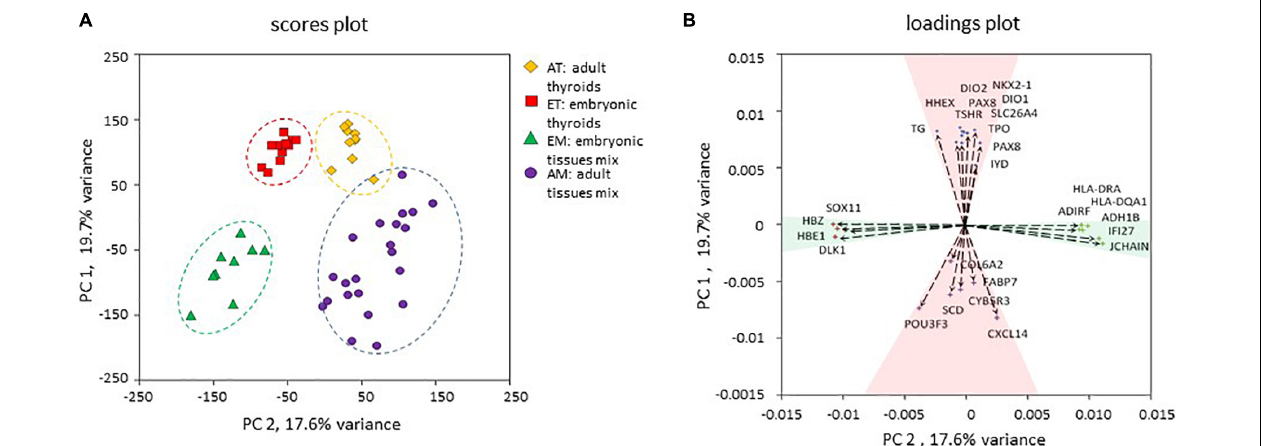
FIGURE 3 | Principal component analysis. (A) Principal component analysis of the four transcriptomic datasets used in the study. The position of each data point corresponding to an individual transcriptome is determined by the first principal component (PC 1) and second principal component (PC 2) scores. PC 1 and PC 2 resolved samples according to their thyroid identity and developmental stage respectively. (B) Contribution of individual genes to PC 1 and PC 2. Genes with the strongest upregulation in thyroid compared to non-thyroid samples (TPO, TG, TSHR, NKX2-1, PAX8, HHEX, FOXE1, DIO1, DIO2, IYD) and genes with the strongest upregulation in other tissues compared to thyroid (SCD, COL6A2, FABP7, POU3F3, CYB5R3, CXCL14) were among the strongest contributors to the PC 1. Non-tissue-specific genes that demonstrated a higher expression in adult tissues (JCHAIN, HLA-DQA1, ADH1B, ADIRF, HLA-DRA, IFI27) or in embryonic tissues (HBZ, DLK1, HBE, SOX11) contributed more strongly to the PC 2. Genes are depicted as vectors with coordinates corresponding to PC1 and PC2 rotations.